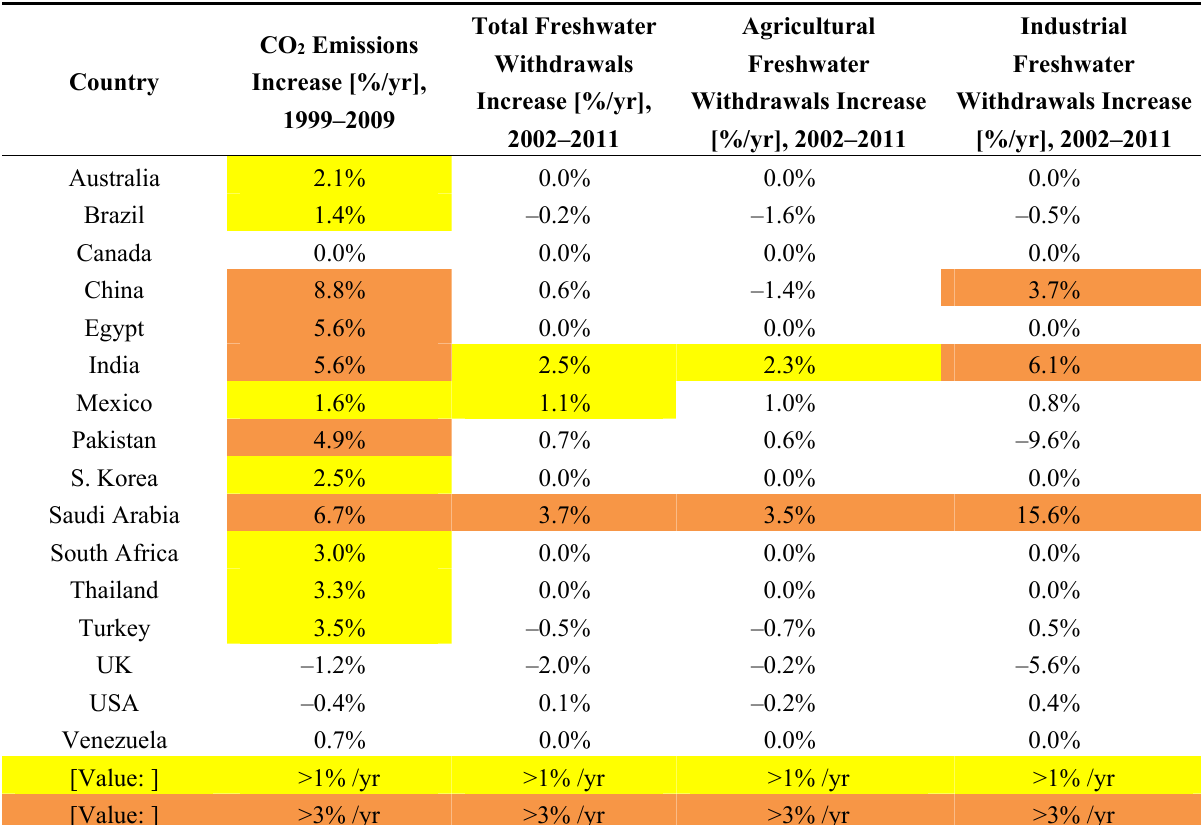
Table 2. Increases in carbon dioxide emissions, agricultural freshwater withdrawals, and irrigation freshwater withdrawals based on reported data (FAO AQUASTAT) [26]. Color coding shown at bottom of